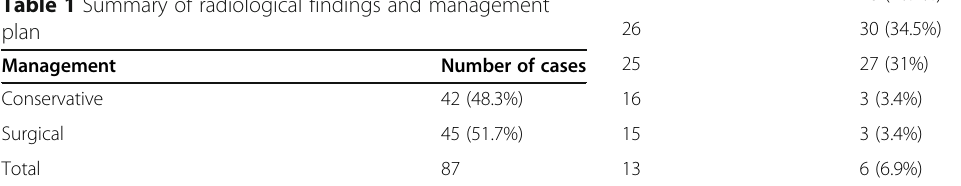
Table 1 Summary of radiological findings and management